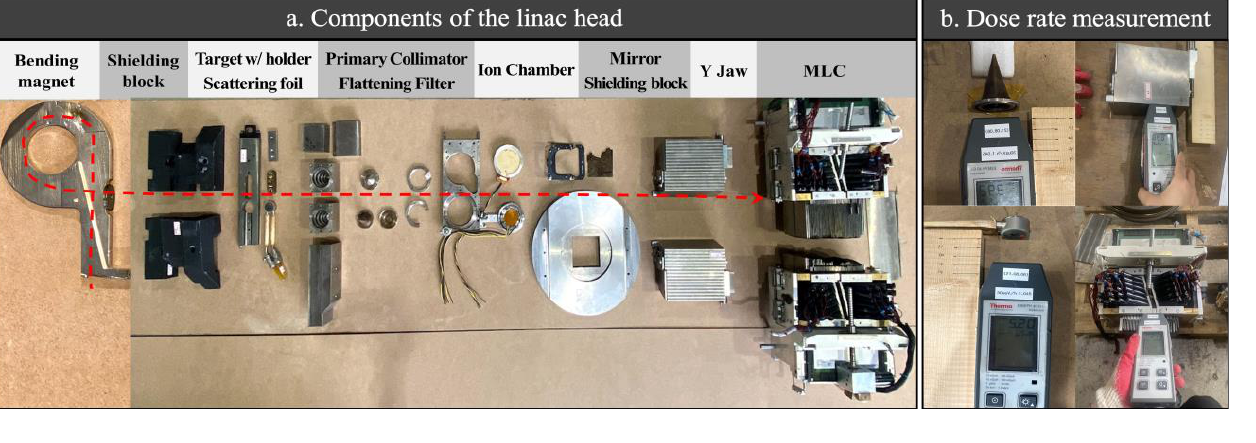
Figure 3. ( a ) Classifying the components of the Siemens linac head and ( b ) survey meter for measuring the dose rate.